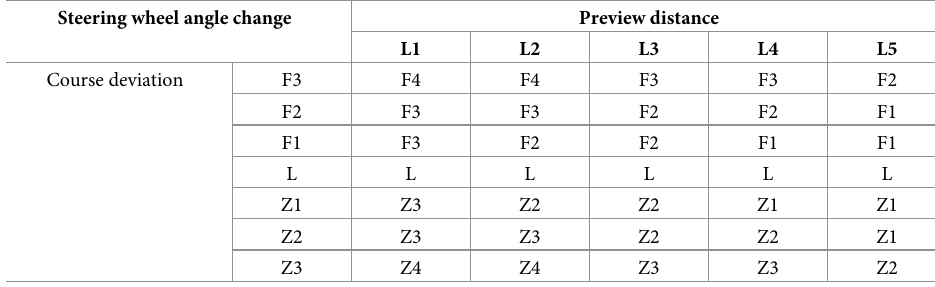
Table 2. Fuzzy control